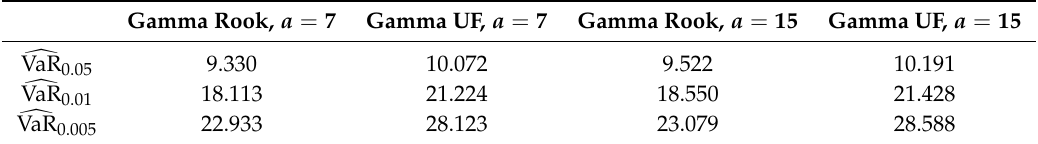
Table 5. VaR estimates with Gamma